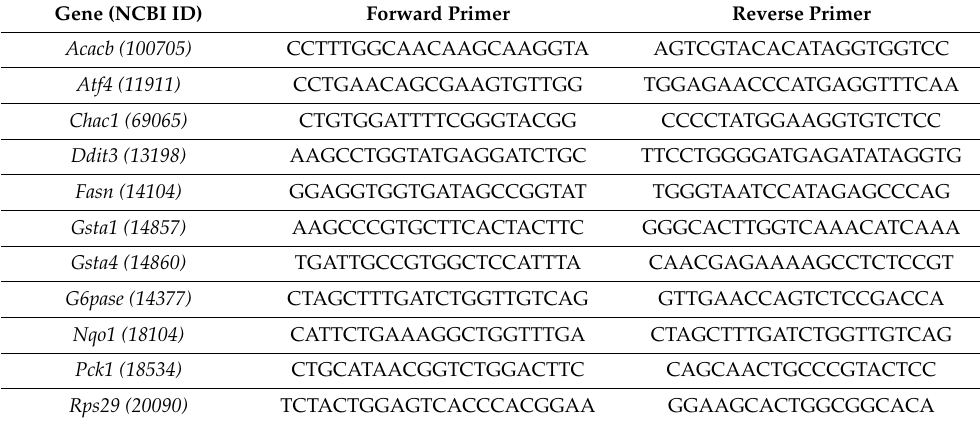
Figure 1. ( A ). Schematic representation of the protocol used for the in utero calorie restriction in pregnant mice. The image suggests that under calorie restriction the embryonic body weight is significantly decreased. This is verified in our experiments, ( B ) where we can see a significant decrease in the body weight of the WT embryos at gestational day 16 among the population that has been exposed to maternal calorie restriction (CR). Control: mothers fed ad libitum. * p < 0.05. Figure 1A was created with Biorender.com. Table 1. Primers sequences used for